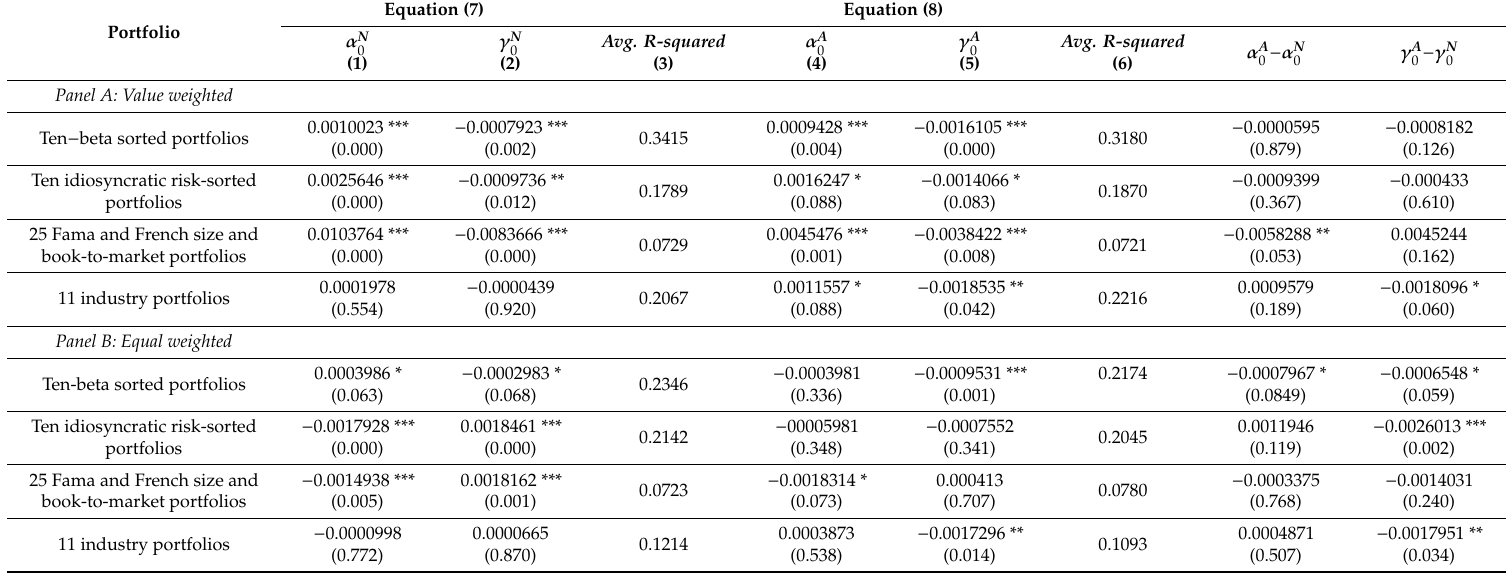
Table 4. Estimation results of Equations (7) and